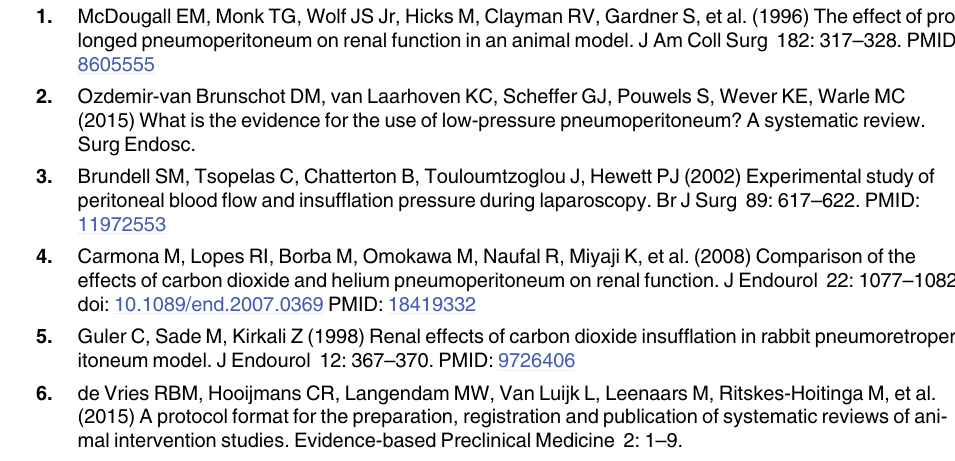
S1 Table. Individual quality assessment and risk of bias scores.